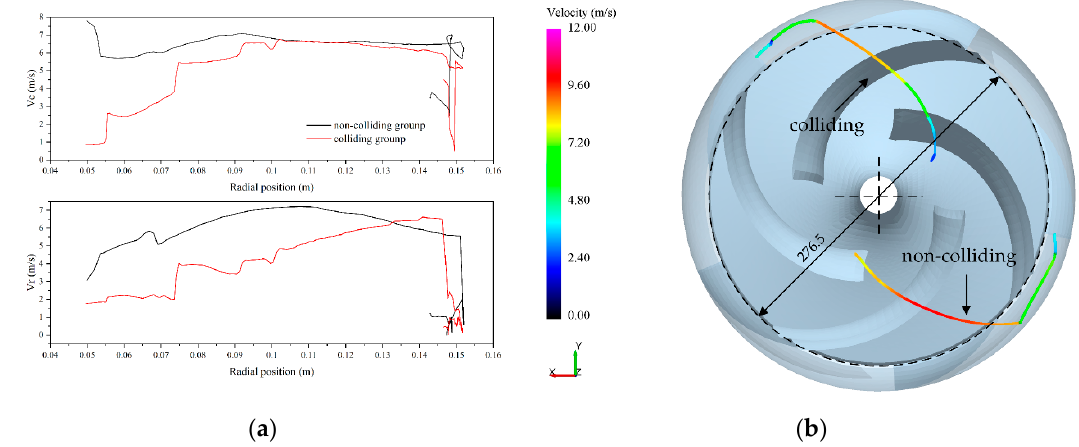
Figure 15. ( a ) Circumferential and radial velocity of two selected particles in the first stage; ( b ) particle trajectory in the first stage.